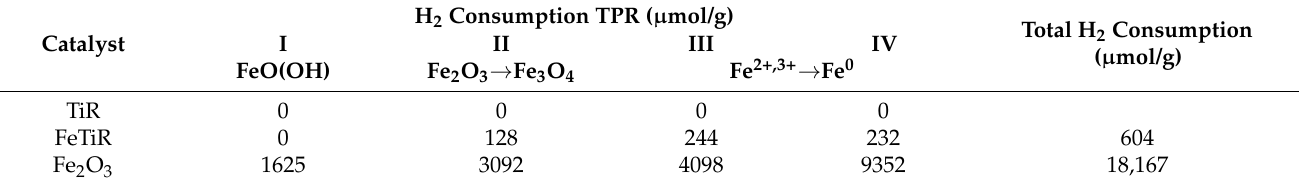
Table 2. The H 2 -TPR results for TiR, FeTiR and Fe 2 O 3 catalysts.